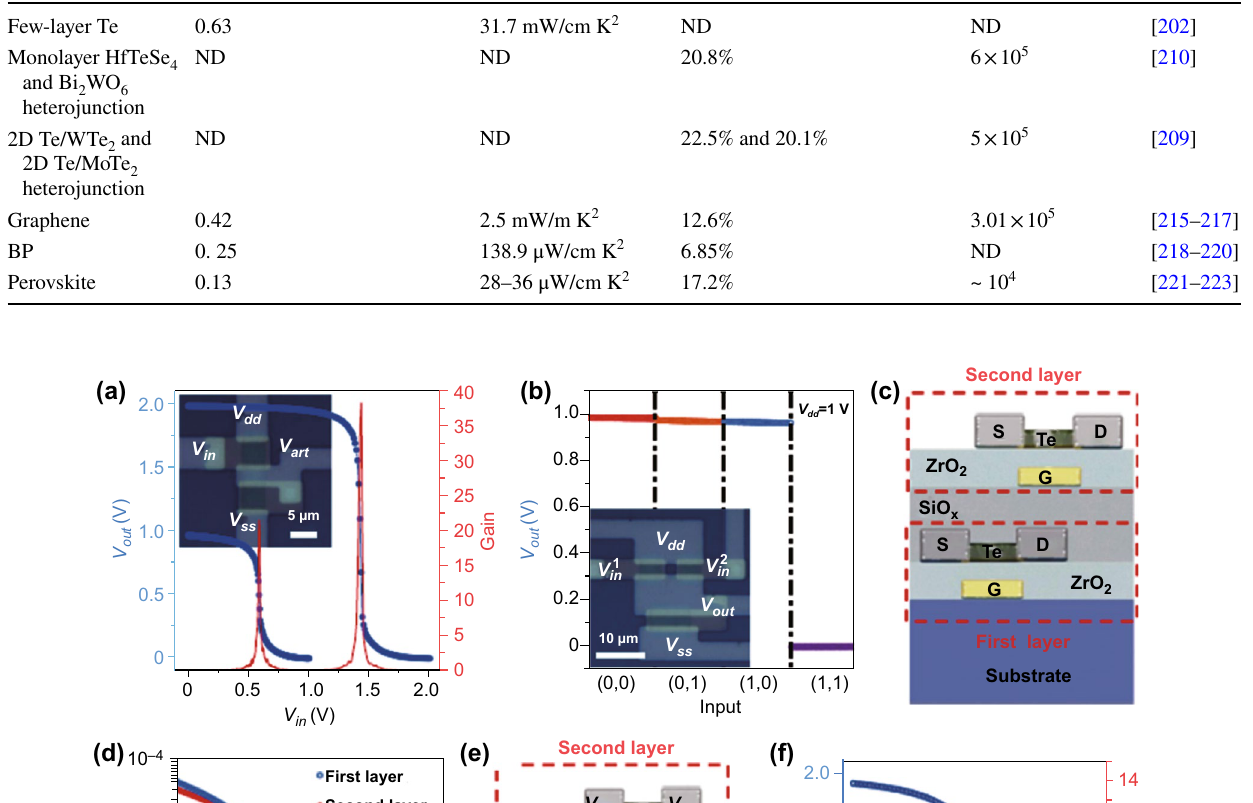
Table 3 Typical energy harvesting device performance based on 2D Te and other 2D materials Material Thermoelectric figure of merit: ZT (room temperature)